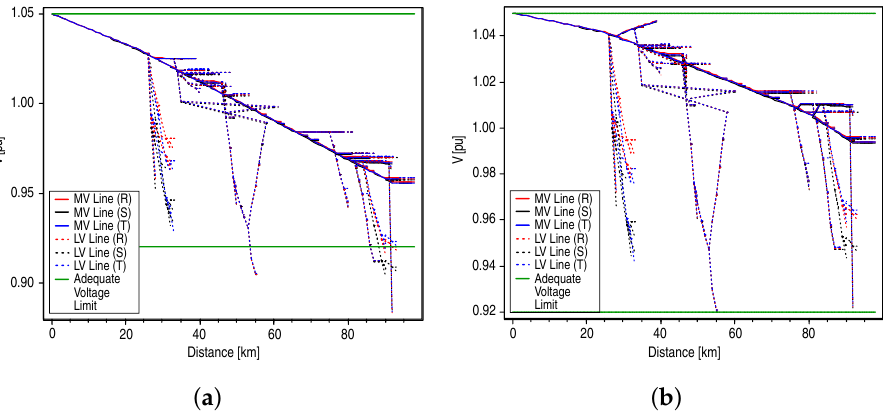
Figure 16. Scenario 3: ( a ) voltage profile before DGPV allocation and ( b ) voltage profile after DGPV